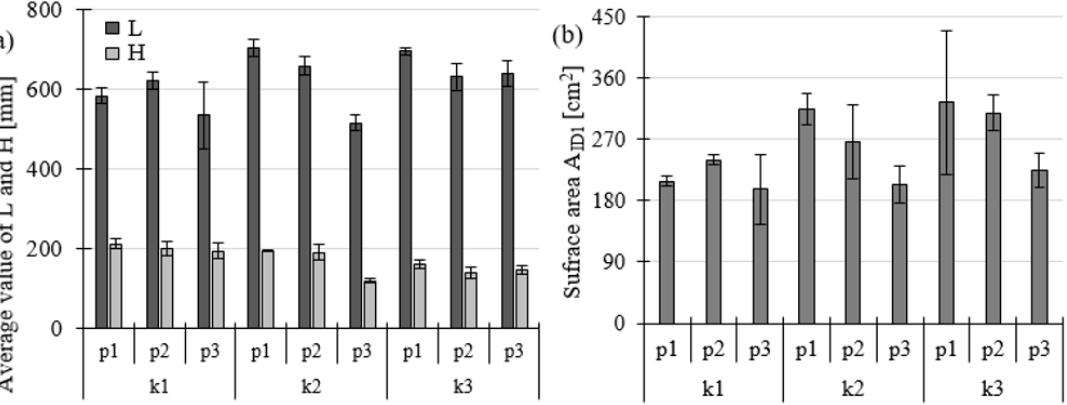
Figure 14. Designated values ( a ) mean value of 𝐿 and 𝐻 and ( b ) mean value of surface area 𝐴 𝐼𝐷1 .